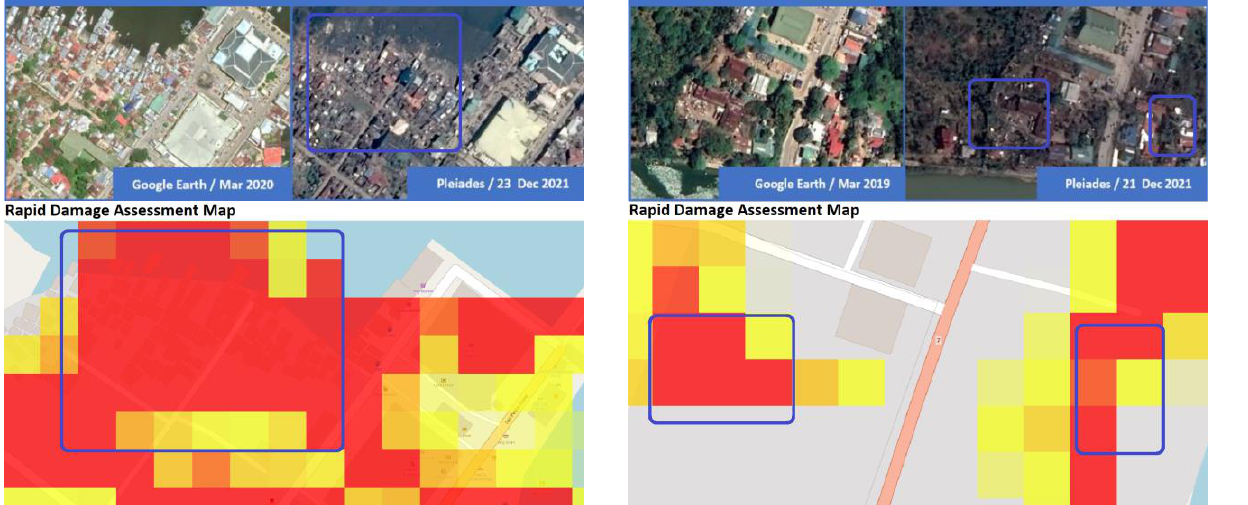
Figure 3. Sample rapid damage assessment map at Talibon, Bohol. Violet bounding box highlights the corresponding location of the damaged area caused by Typhoon Rai near Talibon Port. Basemap © OSM 2022.